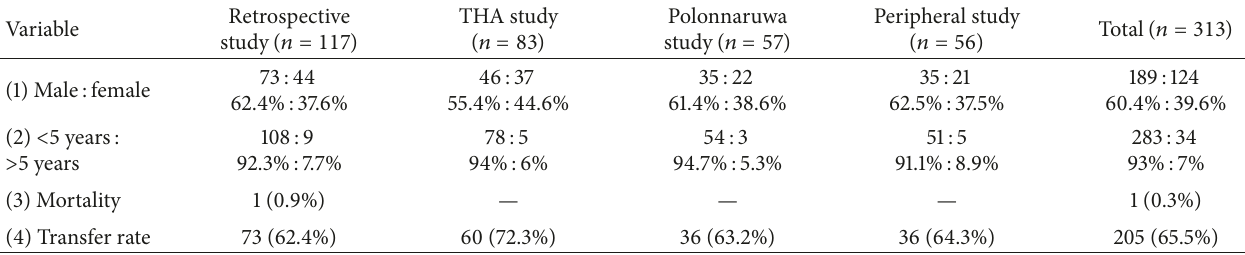
Table 1: Demographic characteristics and transfer rates of children with kerosene oil poisoning. Variable